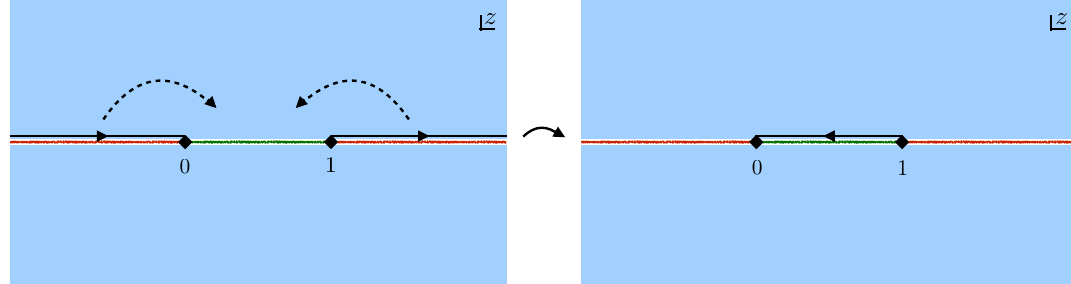
Figure 8. The contour deformation from the Lorentzian to the Euclidean region. The branch cuts of the correlator e ( z ) are shown in red, while the branch cut of the inversion kernels is shown in G green. Figure taken from